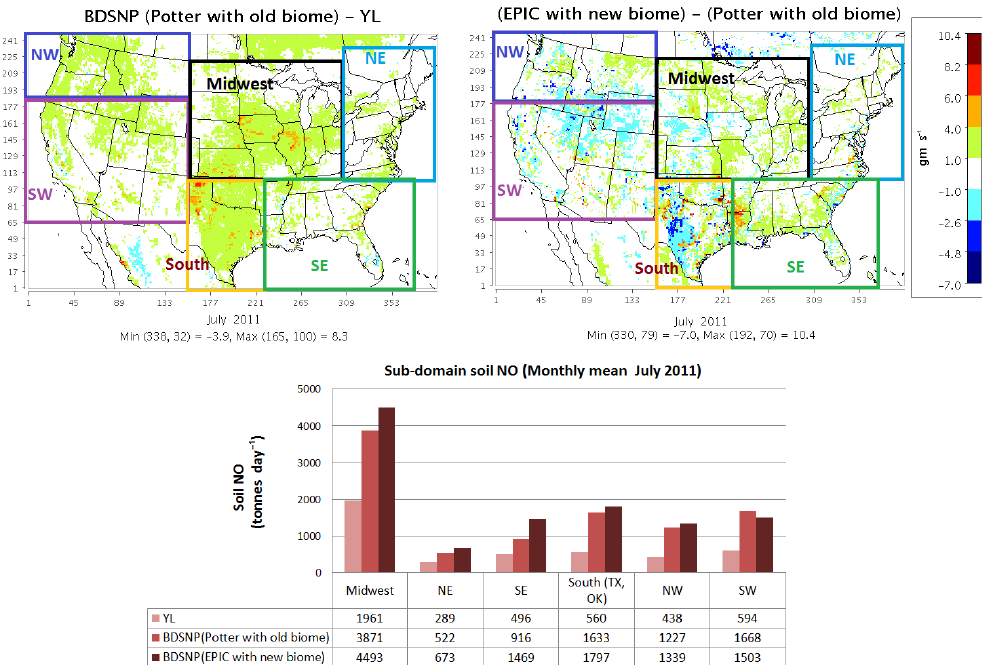
Figure 6. Soil NO (tday − 1 ) sensitivity to change from YL to BDSNP ( et al. (2010) and old biome or “old”) (left) and to the fertilizer and biome scheme within BDSNP (right) over sub-domains (boxes).